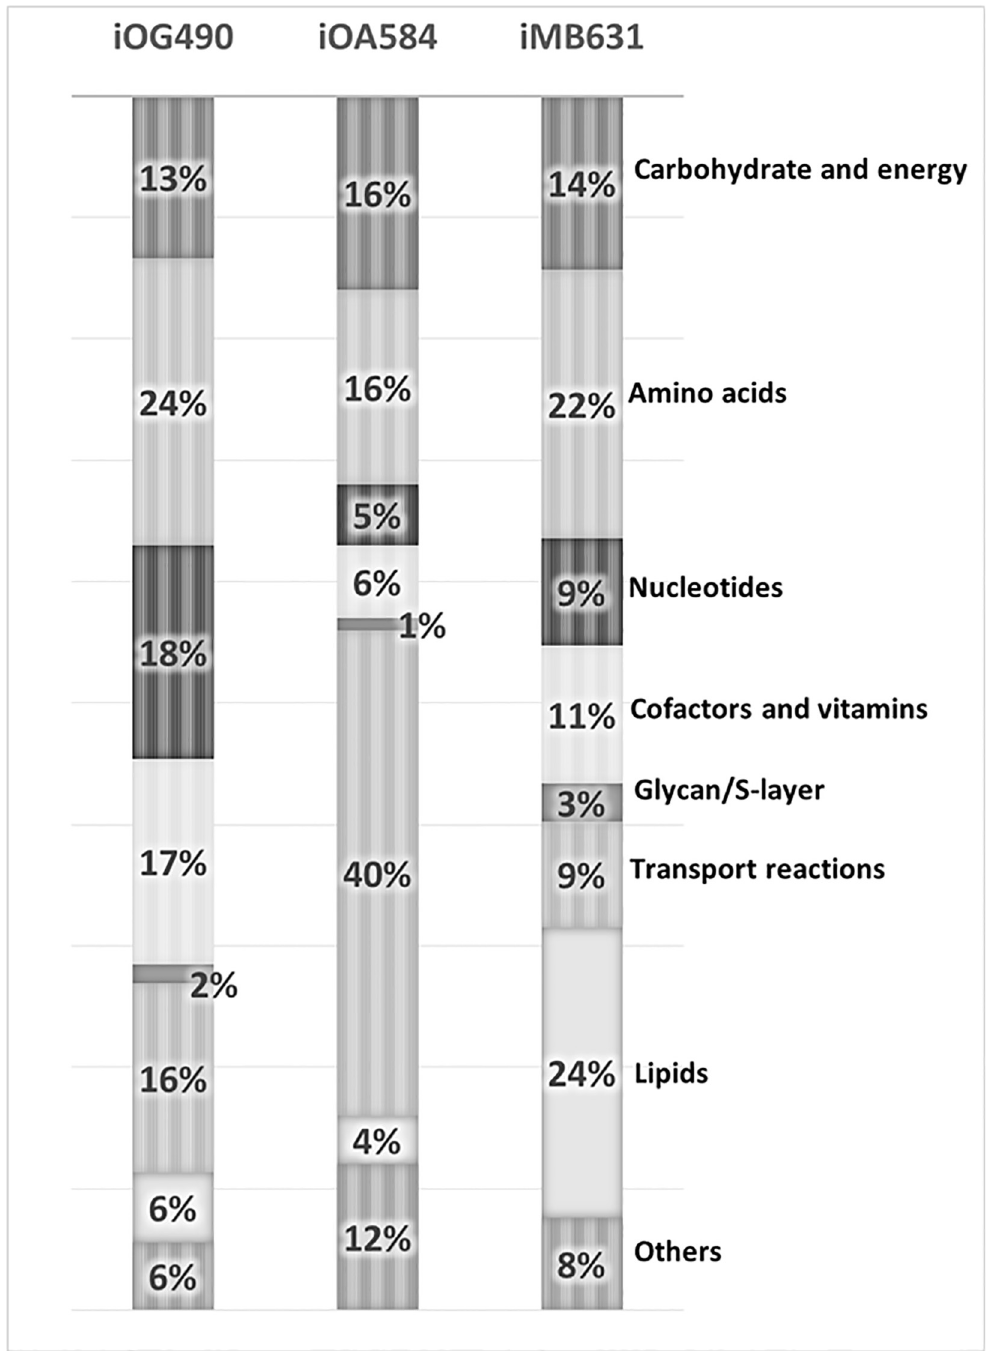
Fig 4. Comparison of reaction distribution in subsystems in three halophilic modes; i MB631, i OA584, i OG490. Amino acid metabolism has the largest number of reactions in both extremophilic models but in moderate halophilic i OA584, transport reaction category is the major one, mostly used to import osmo-protectants and related compounds whereas peptidoglycan or S-layer biosynthesis has the smallest set in all three models.